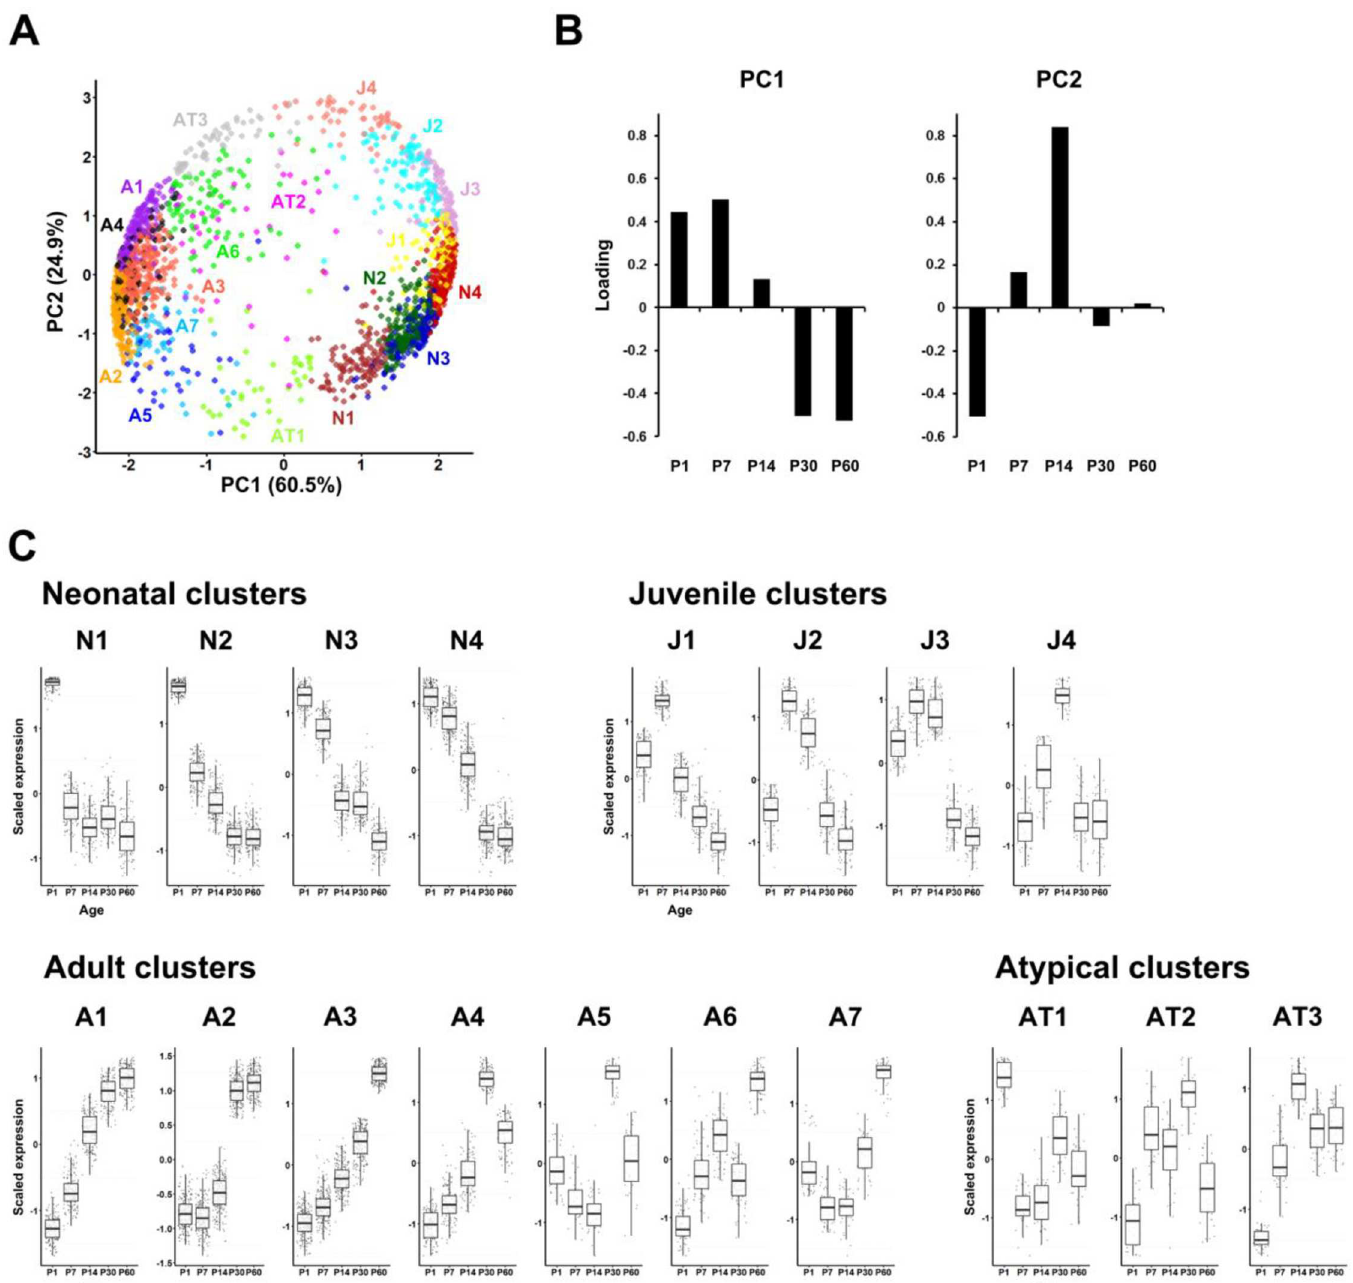
Fig 1. Clustering gene expression patterns during postnatal heart development in control mice. (A) PCA with SOM clusteringof gene expression. The expressionprofile of each gene is represented,and genes belongingto different clusters are indicatedby different colors and separatedby PC1 and PC2. (B) Loadingplots for PC1 and PC2 showingcontributionsof each variable (developmental stage) to the primary components.(C) Expression profiles of each SOM cluster. Scaled expressionalong developmental stages is shown in box plots together with cluster categories and names (Neonatal clusters: N1-N4; Juvenileclusters: J1-J4; Adult clusters, A1-A7; Atypical clusters: AT1-AT3).